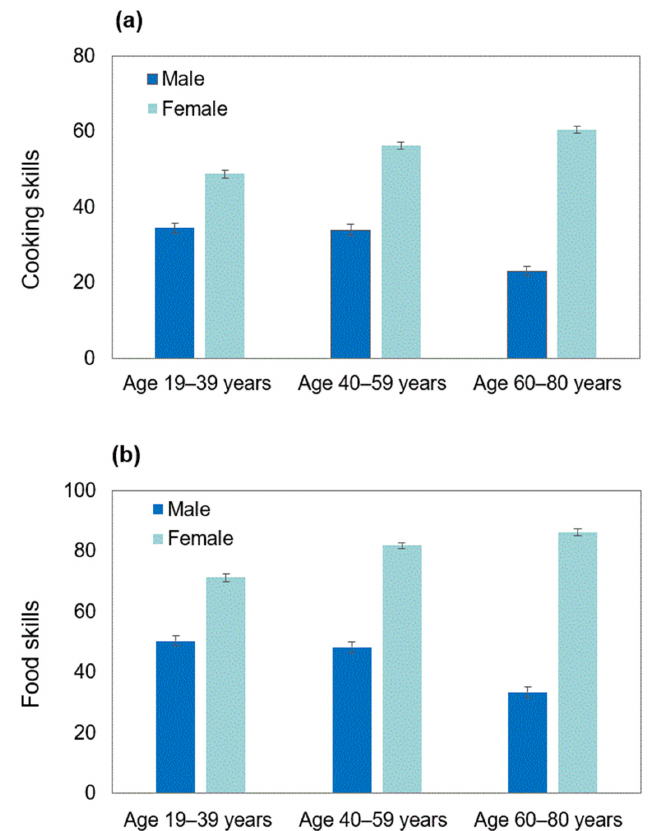
Figure 1. Cooking skills ( a ) and food skills ( b ) according to age category in each sex. Values are means ± standard errors. The possible score is 0 to 98 for cooking skills and 0 to 133 for food skills. The number of males is 332, 359, and 377 for age 19–39, 40–59, and 60–80 years, respectively. The number of females is 375, 392, and 396 for age 19–39, 40–59, and 60–80 years, respectively. In males,